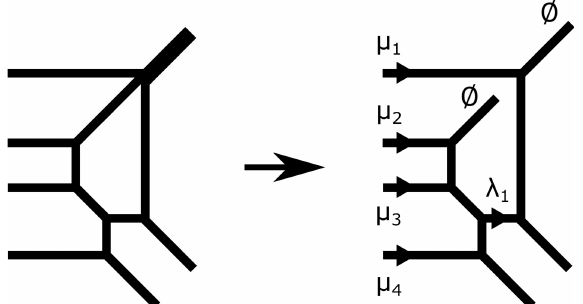
Figure 27. The diagram on the right-hand side shows the assignment of Young diagrams for applying the topological vertex to the diagram on the left-hand